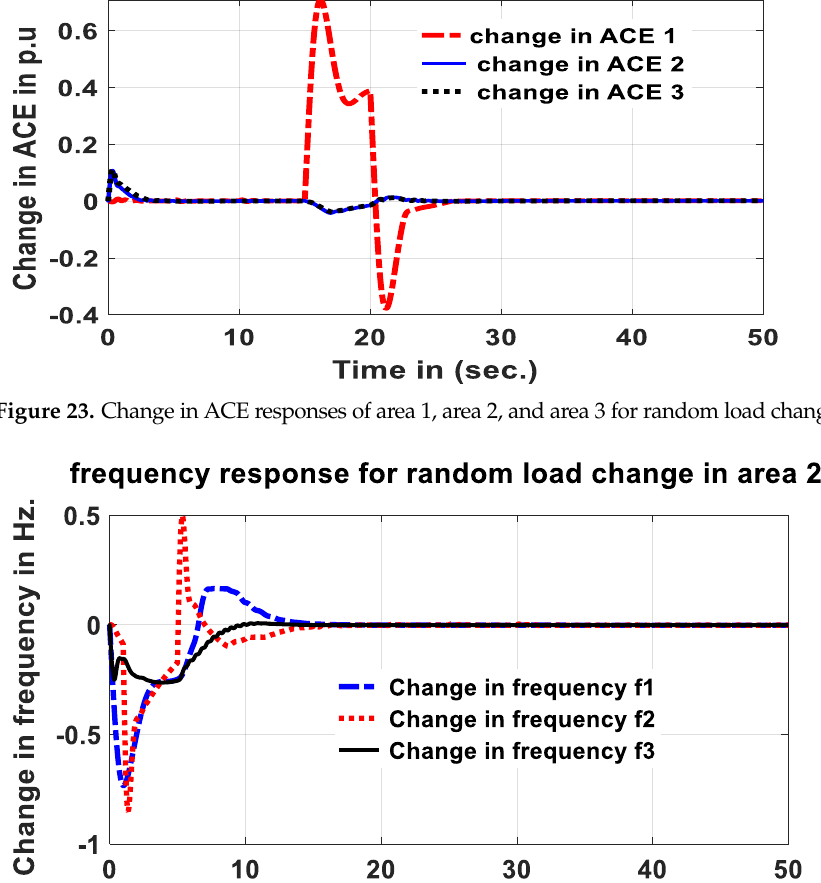
Figure 22. Change in tie-line responses of area 1,area 2, and area 3 for random load change in area 1 only.